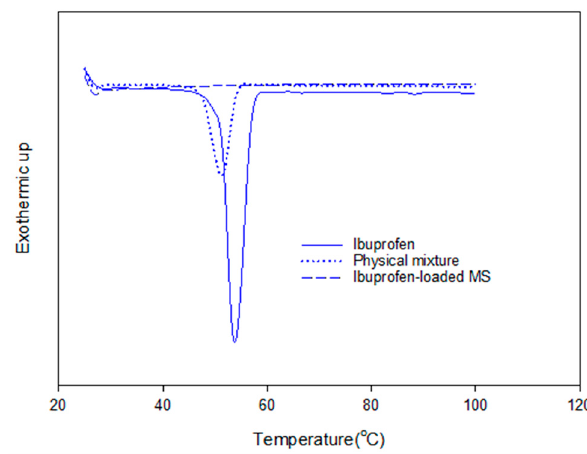
Figure 8. DSC thermograms of crystalline ibuprofen, physical mixture (MS and ibuprofen) and ibuprofen-loaded MS.